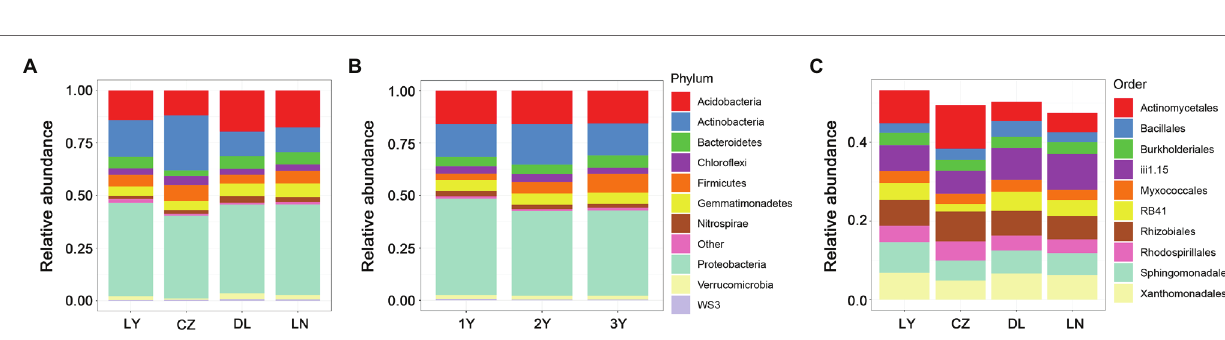
FIGURE 1 | Diversity of the rhizosphere bacterial communities of Sophora flavescens . (A,B) The number of specific and shared operational taxonomic units (OTUs) of the rhizosphere bacterial communities from different geographic locations (A) or between different plant ages (B) . (C–E) The alpha diversity, including species richness (C) , Chao1 index (D) , and Shannon index (E) , of the bacterial communities in the rhizosphere samples from different geographic locations. Different lowercase letters indicate significant differences among geographical locations ( P < 0.05). LN: Lingyuan; CZ: Changzhi; DL: Dali; LN: Luonan. 1Y: 1-year-old; 2Y: 2-year-old; 3Y: 3-year-old.